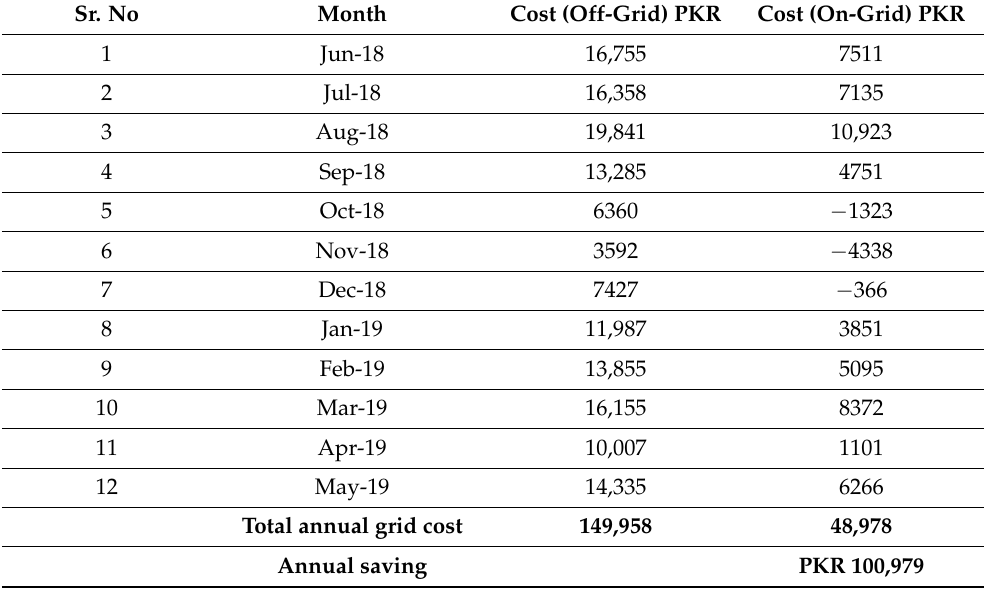
Table 4. Month-wise costing comparative analysis.